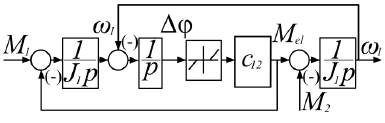
Fig. 7. Structural diagram of a two-mass system with the